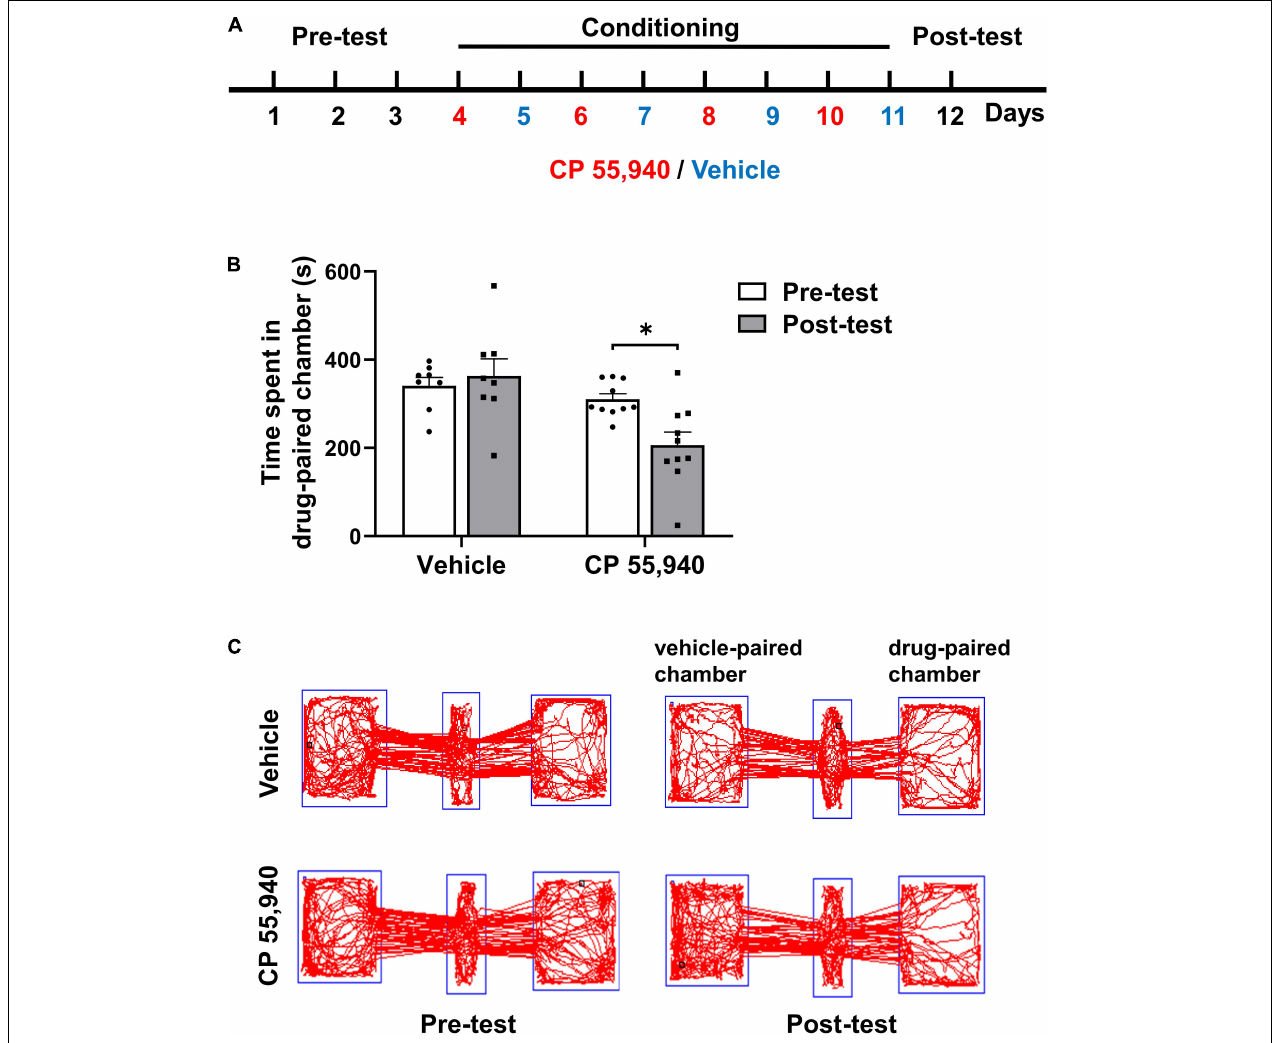
FIGURE 1 | CP 55,940 at a dose of 1 mg/kg induces conditioned place aversion in mice. (A) The conditioned place preference (CPP) paradigm conducted in a three-chambered apparatus. During the conditioning phase mice received intraperitoneal injections of vehicle (blue) in the black chamber on odd days and CP 55,940 (red) in the white chamber on even days. (B) Mice injected with CP 55,940, but not vehicle, displayed a significant decrease in time spent in the drug-paired chamber. ∗ P < 0.05 (one-way ANOVA, Welch and Brown–Forsythe test). (C) Representative tracks illustrating CP 55,940-induced aversion in mice.